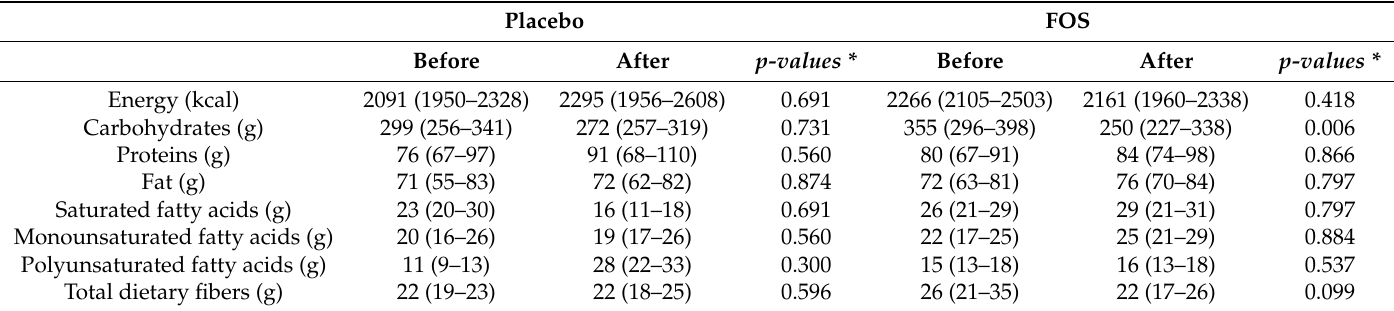
Table 2. Estimated nutrients intake “before” and “after” the supplement intervention, by